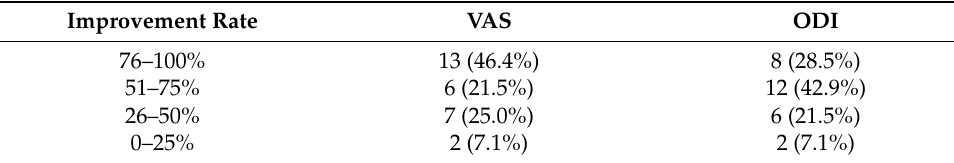
Table 4. Improvement rate of patients after interlaminar PED.